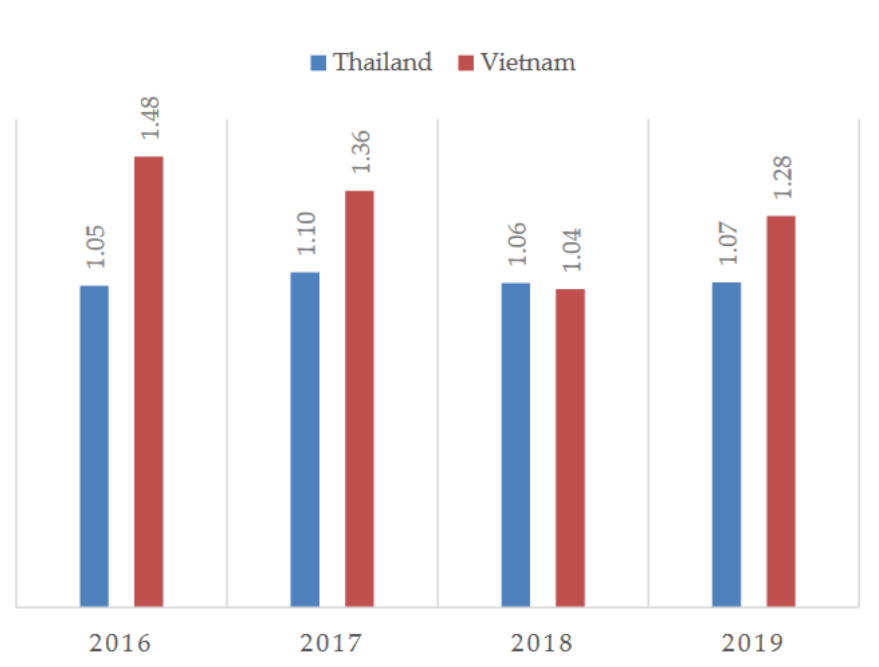
Figure 3. Average efficiency score between Thailand and Vietnam. Figure 3. Average e ffi ciency score between Thailand and